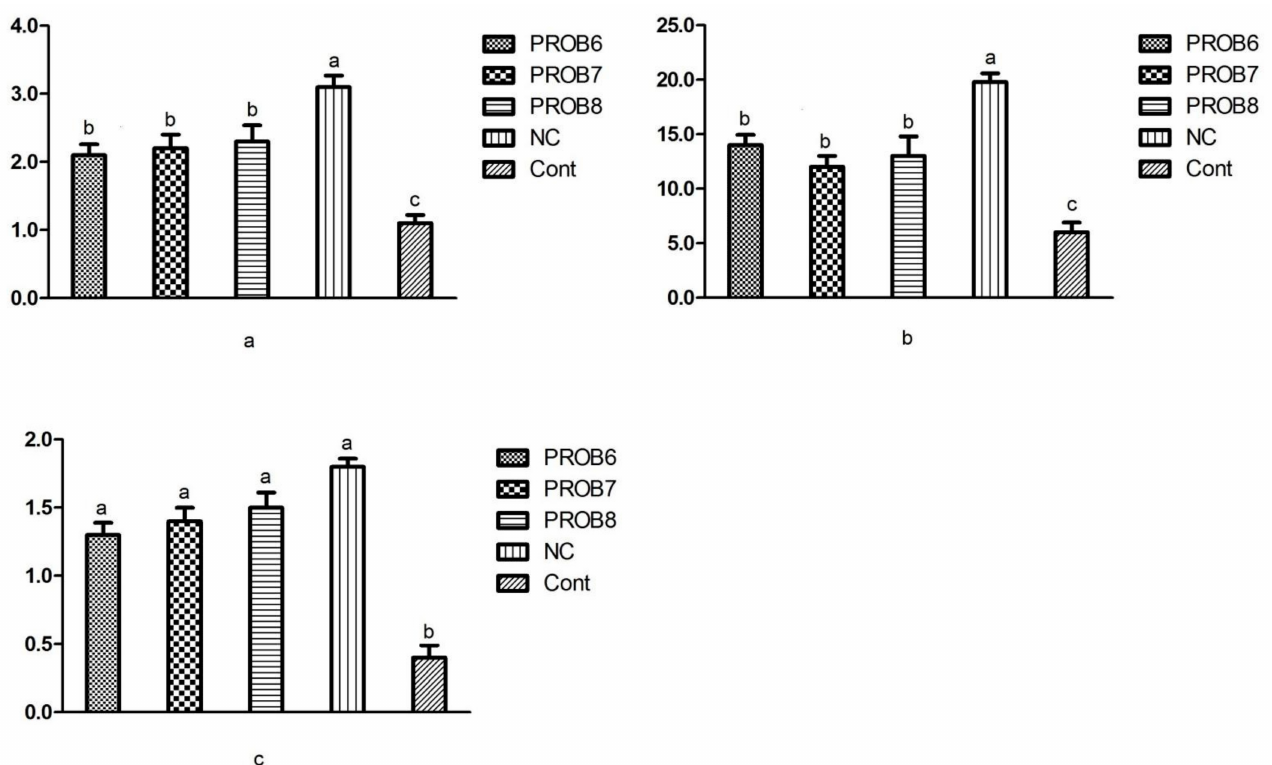
Figure 7. mRNA expression levels of antioxidant enzyme and PepT 1: ( a ) SOD expression level; ( b ) CAT expression level; ( c ) PepT 1 expression level. Means with different superscripts (a, b, c) are significantly different ( p < 0.05). PROB6 = L. plantarum (1 × 10 6 CFU) supplemented group in feed; PROB7 = L. plantarum (1 × 10 7 CFU) supplemented group in feed; PROB8 = L. plantarum (1 × 10 8 CFU) supplemented group in feed; NC = infected, non-medicated treatment group; Cont = non-infected, non-medicated treated